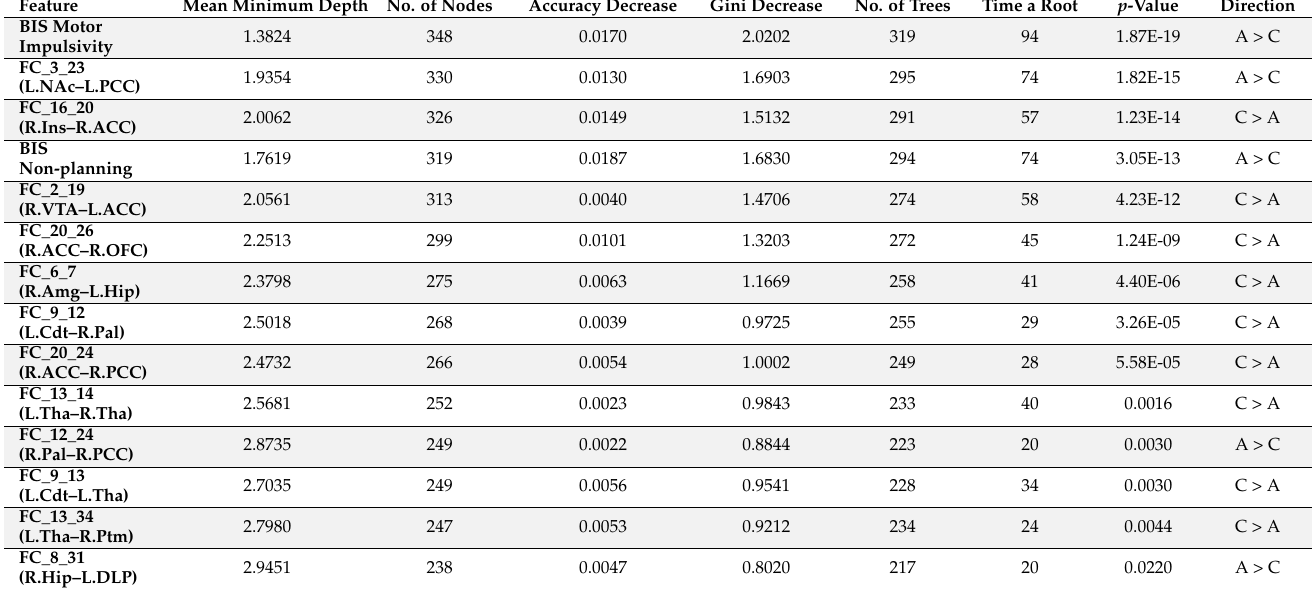
Table 3. Random forest importance parameters mean minimal depth, number of nodes, accuracy decrease, Gini decrease, number of trees, times a root, and p -value), and the direction of significance for the top significant variables ( p < 0.05) are shown. Two of the impulsivity scores (motor and non-planning) and 12 rsFC connections were identified as important features to classify individuals into either AUD or CTL group. The variables are sorted based on the p